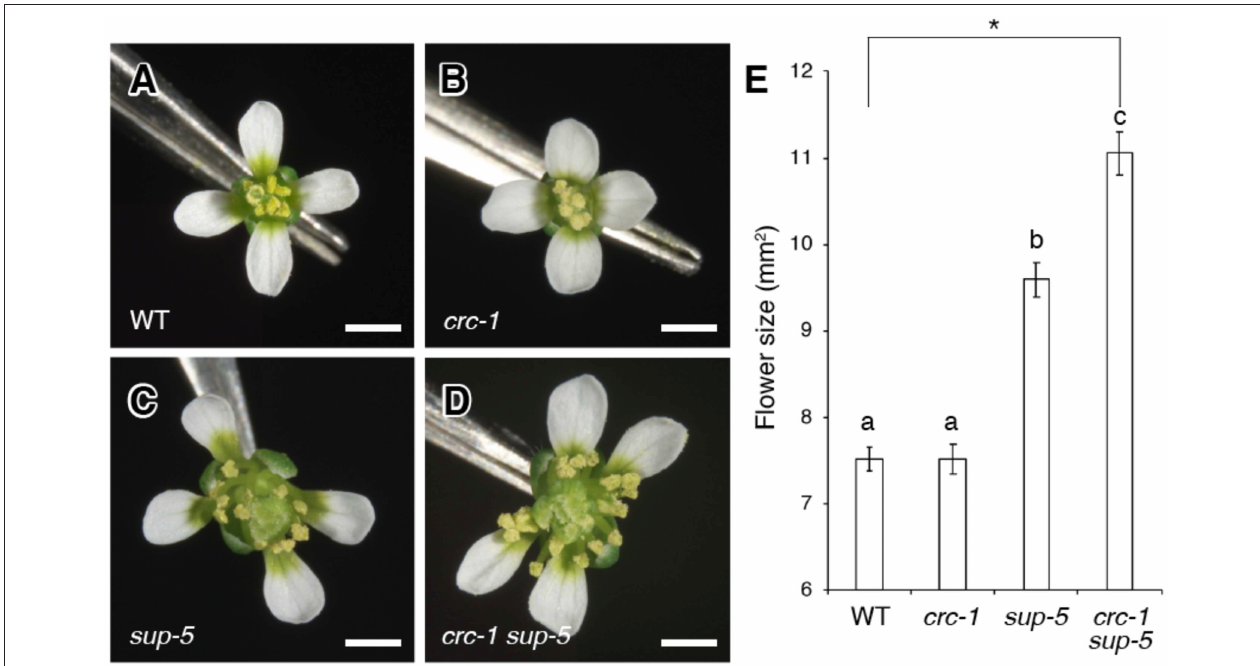
FIGURE 1 | Comparison of flower size among the wild type, crc-1 , sup-5 , and crc-1 sup-5 at floral stage 13. (A–D) Top view of flowers. (A) The wild type (WT), (B) crc-1 , (C) sup-5 , and (D) crc-1 sup-5 . Scale bars represent 500 µ m. (E) Quantification of flower size. Mean ± SEM are shown. The asterisk indicates significant difference based on one-way ANOVA. The same letters indicate non-significant differences, whereas different letters indicate significant differences based on the post-hoc Tukey HSD test ( p <